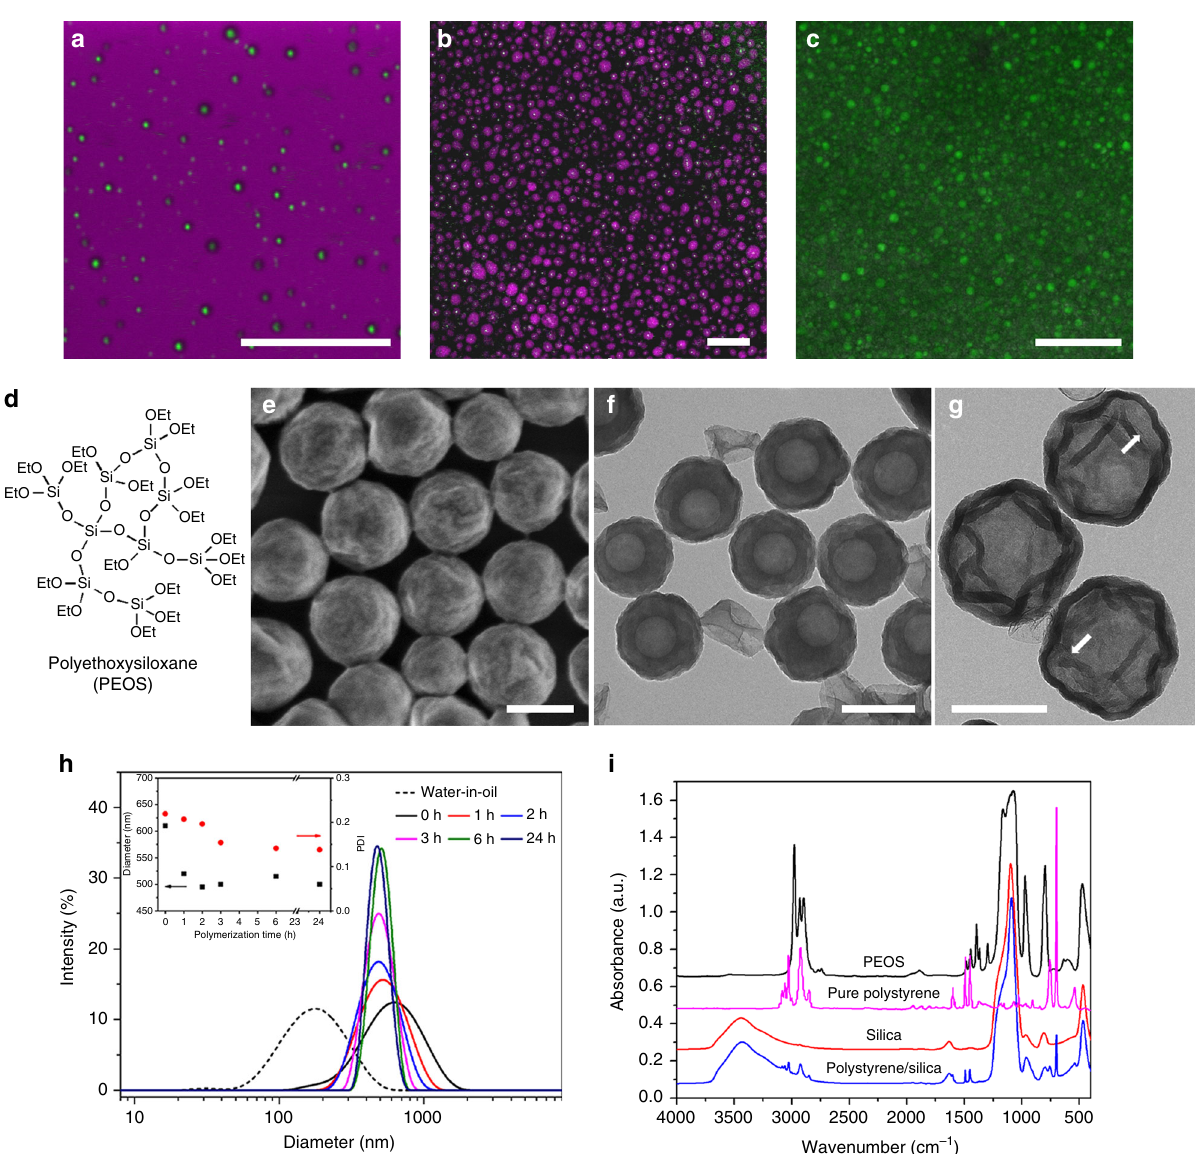
Fig. 1 Transformation of a double miniemulsion to nanocapsules. a – c Fluorescence micrographs of primary water-in-styrene/PEOS emulsion, water-in- styrene/PEOS-in-water double emulsion, and resulting water@SiO 2 @polystyrene@SiO 2 nanocapsules, respectively. The mass ratio of PEOS to styrene is 1:1, the inner water phase to the oil phase is 1:10, and the primary W/O emulsion to the outer water phase is 1:10. The pH value of the water phase is 7. Pink color represents the oil phase labeled with Nile red and green color shows the aqueous phase labeled with fl uorescein sodium salt. Scale bars = 5 μ m. d Chemical structure of polyethoxysiloxane (PEOS). e Field-emission scanning electron microscopy (FESEM) and f transmission electron microscopy (TEM) images of the water@SiO 2 @polystyrene@SiO 2 nanocapsules. g TEM image of the particles shown in e and f after calcination in a muf fl e oven, where thin silica layers are pointed out by white arrows. Scale bars in the electron microscopy images are 200 nm. h Size distribution of the primary W/O emulsion and size evolution of the W/O/W double emulsion during polymerization measured by dynamic light scattering. PDI is polydispersity index. i Fourier- transform infrared spectra of PEOS, pure polystyrene, dried water@SiO 2 @polystyrene@SiO 2 nanocapsules, and silica material obtained after calcination of the nanocapsules at 600 °C in